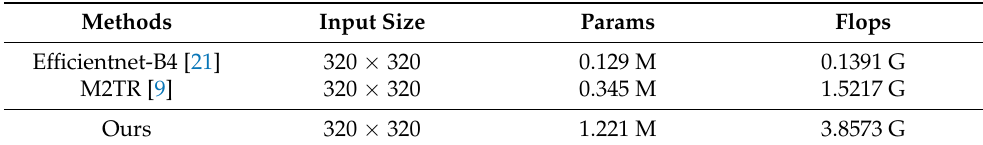
Table 6. Time-complexity comparison table with the state-of-the-art. Methods